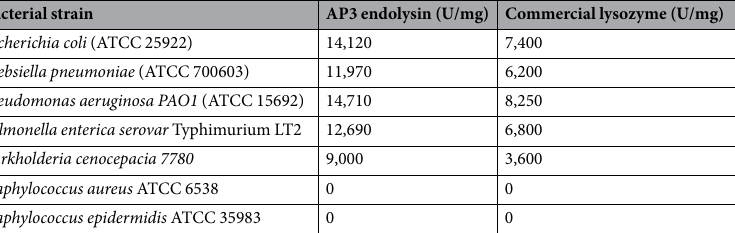
Table 2. The muralytic activity of phage AP3 endolysin and commercially available lysozyme (Sigma Aldrich, Poland) against selected bacterial